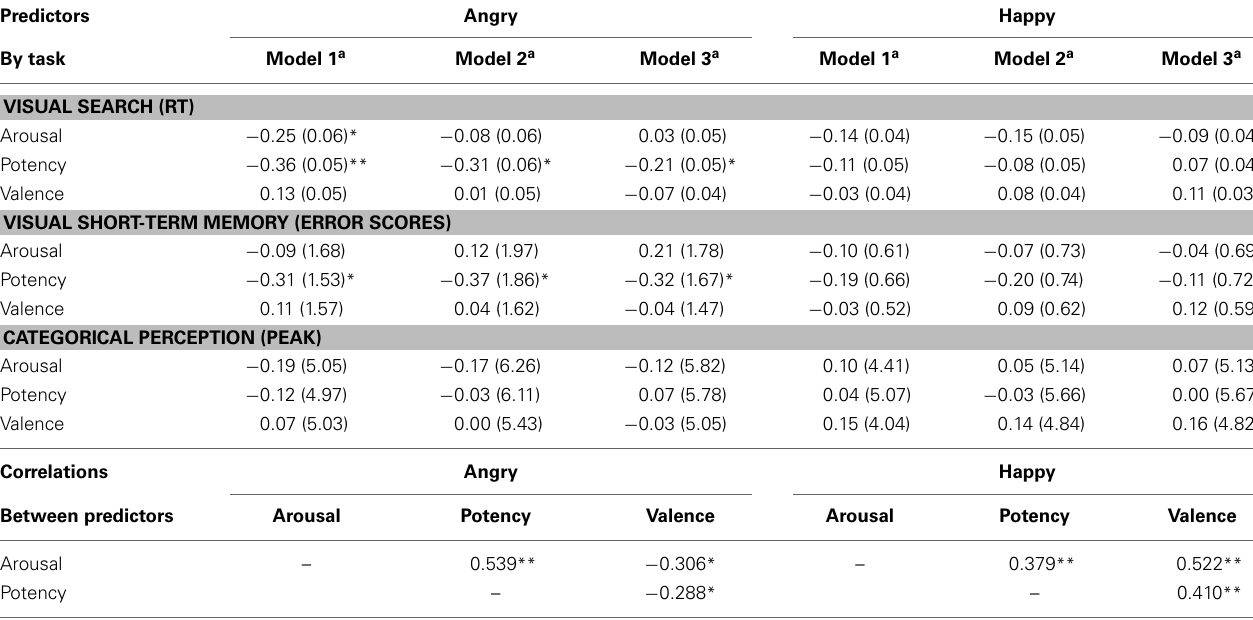
Table 2 | β -coefficients (SE) and bivariate correlations for rating scores associated with emotional behavior.